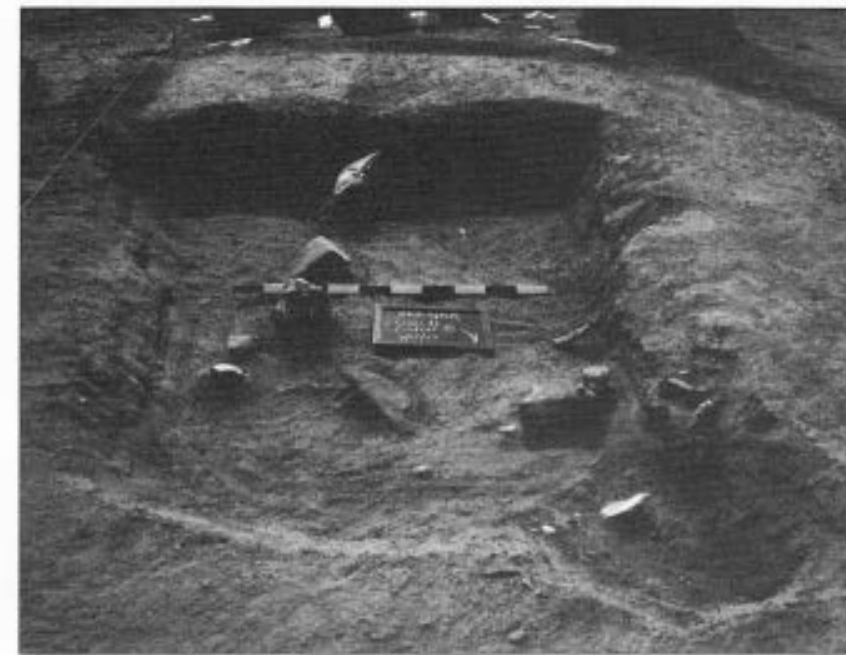
Figure 4 Tomb 14, looking south, with both the elephant jaw and a sherd of white cross­ lined pottery in situ that indicated the date of the burial (scale bar: 10cm